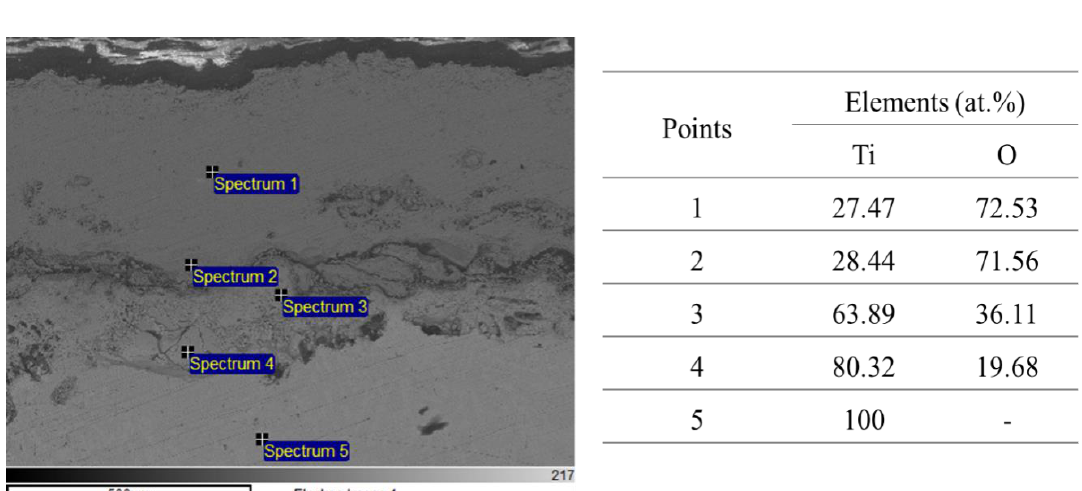
Figure 4. SEM image of the oxidized Ti at 700 ◦ C for 100 h.